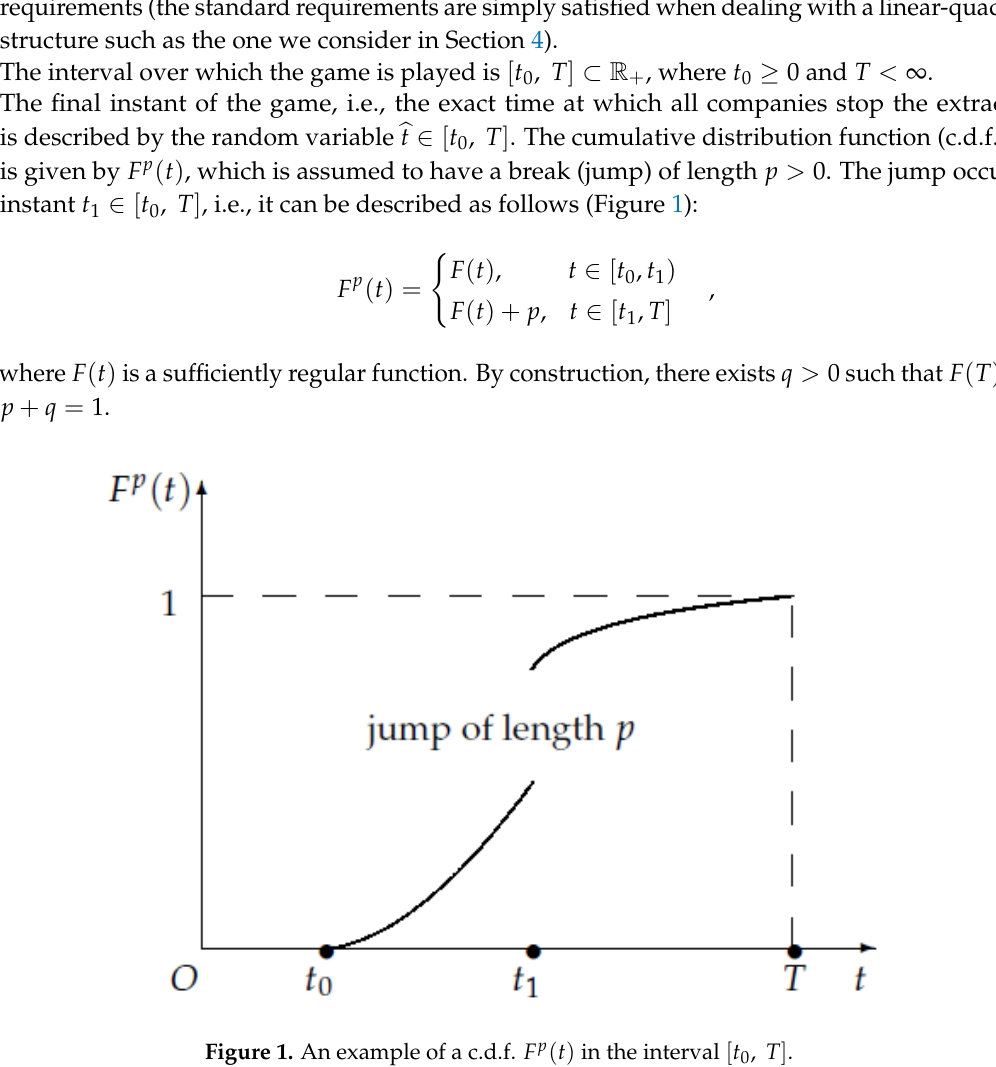
Figure 1. An example of a c.d.f. F p ( t ) in the interval [ t 0 , T ]